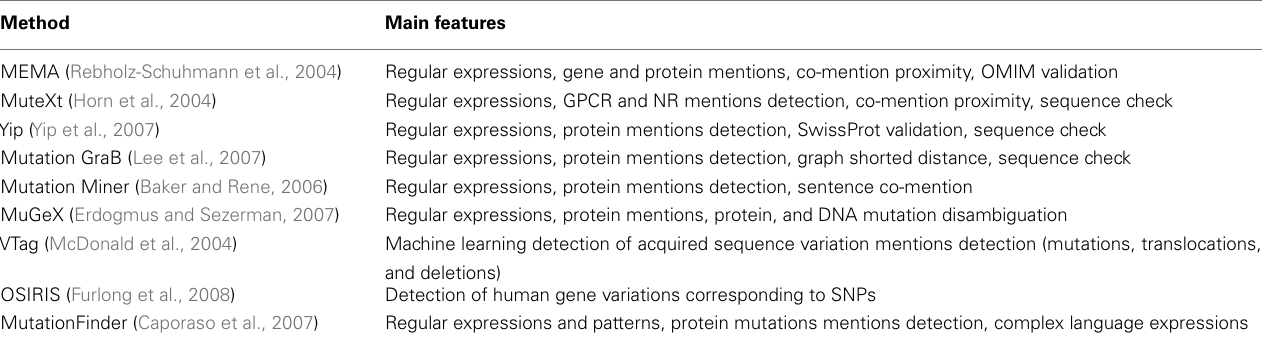
Table 3 | Summary of text mining implementations for mutation